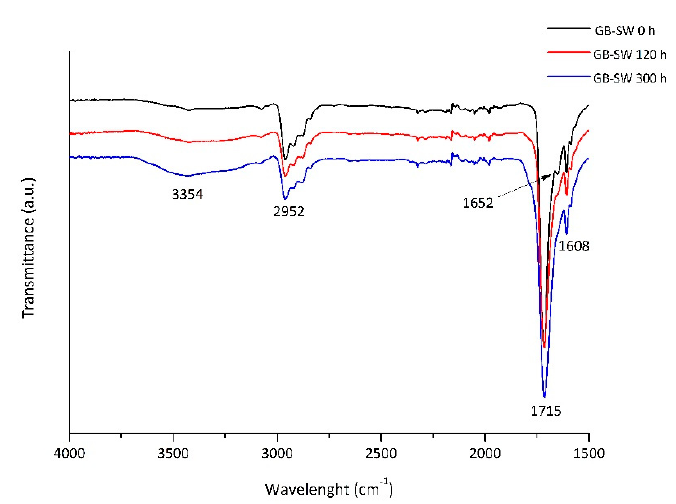
Figure 8. FT-IR spectra of the GB-SW sample before exposure, after 120 h, and after 300 h of UVB irradiation.